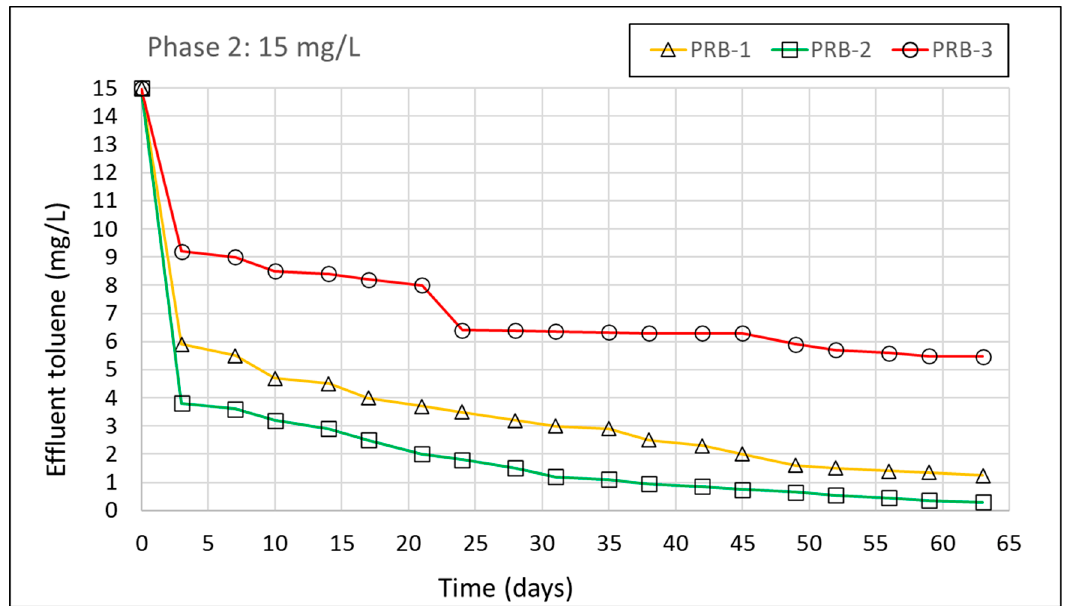
Figure 3. Changes in toluene concentrations in the PRB columns for phase 2. Results of phase 3: In phase 3, toluene concentration in the influent tank for three PRB reactors was prepared as 25 mg/L. Toluene removal rates for 25 mg/L influent are depicted in Figure 4. After 54 days of treatment, toluene concentrations were decreased from 25 to 7.85 mg/L (greater than the threshold value of 0.7 mg/L set by WHO) by the natural attenuation treatment (PRB-3) process, which represents a 68.6% removal efficiency. In PRB-1, toluene was reduced from 25 to 1.54 mg/L (greater than the threshold value of 0.7 mg/L), which represents a removal efficiency of 93.8%. In PRB-2, toluene was reduced from 25 to 0.465 mg/L (less than the threshold value of 0.7 mg/L), which represents a removal efficiency of 98.1%.